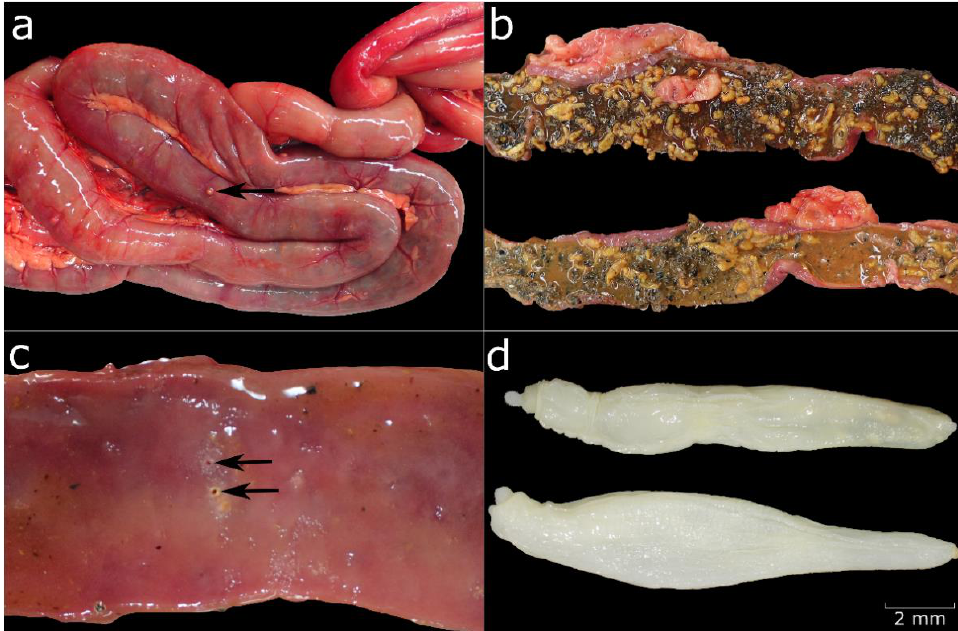
Figure 8. ( a ) Parasite infection of the small intestine with granulomatous enteritis visible on the serosa (black arrow). ( b ) Bright orange parasites in the intestine. ( c ) Ulcerative lesions in the mucosa (black arrows). ( d ) Profilicollis botulus under the stereomicroscope. Table 4. Semiquantitative assessment of the grade of enteritis in relation to the nutritional condi- tion.